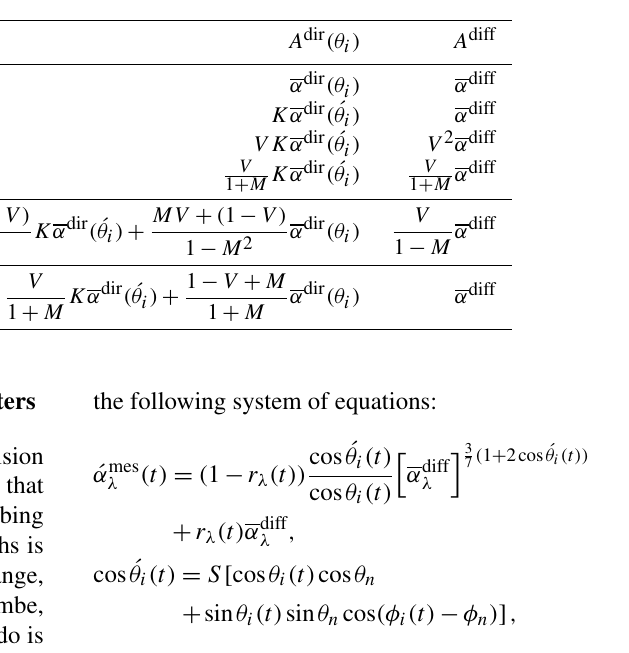
Table 1. Apparent albedo formulation ´ α(θ i ) = ( 1 − ´ r)A dir (θ i ) + ´ rA diff for horizontal terrain, small slopes, and for four configurations with significant slopes depending on whether the neighbourhood is covered by snow or by a dark surface, and the albedo and diffuse-to-total ratio measurements are taken mid-slope or at the top of the slope. The slope is not in its own shadow S( cos ´ θ i ) > 0. We have also introduced M = ( 1 − V )α diff . The λ dependence is implicit for the sake of